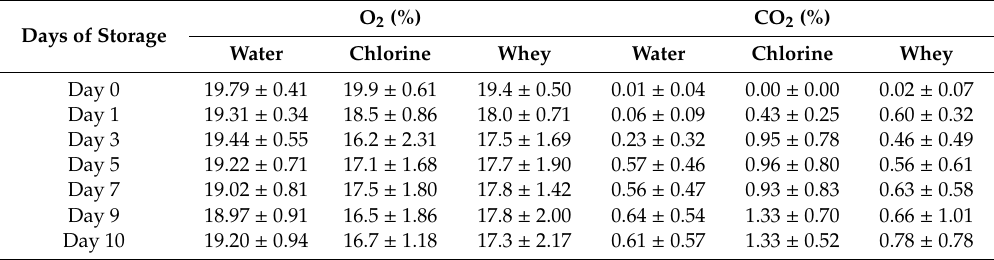
different sanitizer treatments, over 10 days in cold storage. Table 3. Oxygen and carbon dioxide measurements for packed sanitized shredded lettuce with di ff erent sanitizer treatments, over 10 days in cold storage.